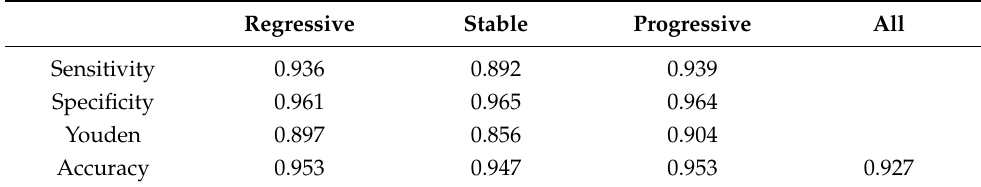
Table 3. Results of the evaluation